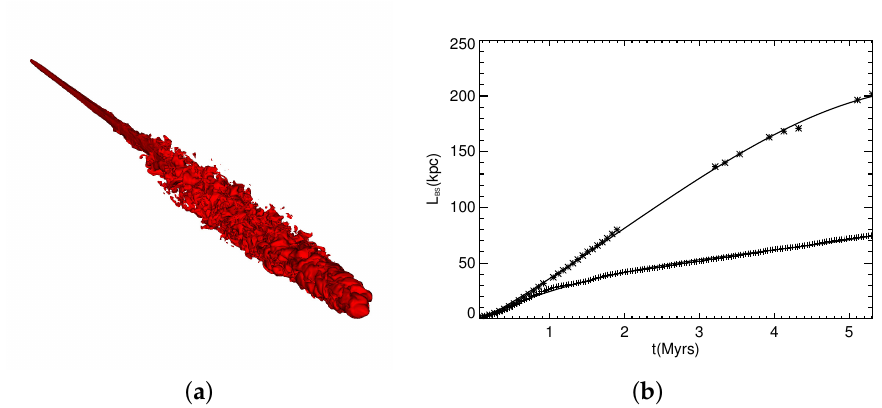
Figure 5. ( a ) The left panel shows the jet-mass fraction 50% isosurface for a 3D RHD simulation of a powerful relativistic jet propagating through a density/pressure gradient typical of an elliptical galaxy [20]. The jet collimation reminds that observed in FRII jets. ( b ) Jet head position versus time for the 3D simulation shown in the left panel and a 2D axisymmetric simulation with the same injection parameters, for comparison; the lines show polynomial fits to the data. The 3D jet propagates faster due to head acceleration produced by the obliquity of the front shock as compared to the planar shock typically observed in 2D simulations (see [20] for a detailed